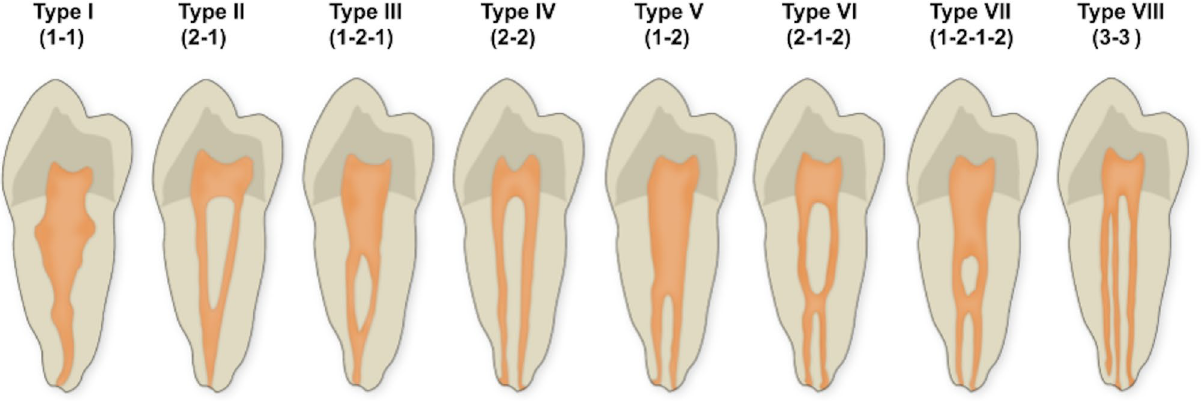
Figure 1. Representative illustrations of the different configuration types of the root canal system morphology according to Vertucci’s